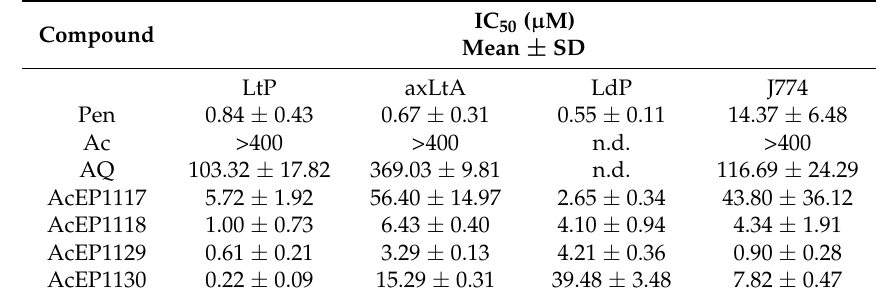
Table 1. IC 50 values of AcEPs along with Pen, Ac, AQ. Values were obtained from resazurin, MTT, or MTS viability assays using serial dilutions of the compounds with an endpoint at 48 h using 2 × 10 6 LtP/mL, 6 × 10 6 axLtA/mL, 5 × 10 5 LdP/mL, or 10 5 J774/mL, respectively. Data represent mean ± SD from at least 3–8